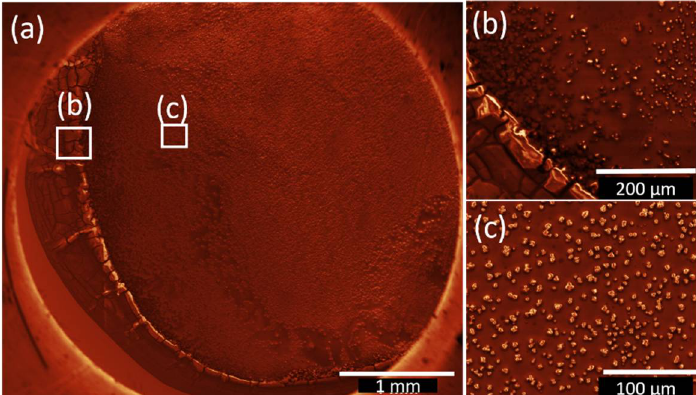
Figure 5. SEM image of 2 –DrA film after the evaporation of the solvent. The images were treated with the Gwyddion.net image filter from Gwyddion software: ( a ) full drop shows the coffee stain effect, ( b ) indicates rough film edges as well as large cluster agglomerations at the drop edge, and ( c ) displays the middle part of the droplet with homogeneously distributed agglomerations of similar size.